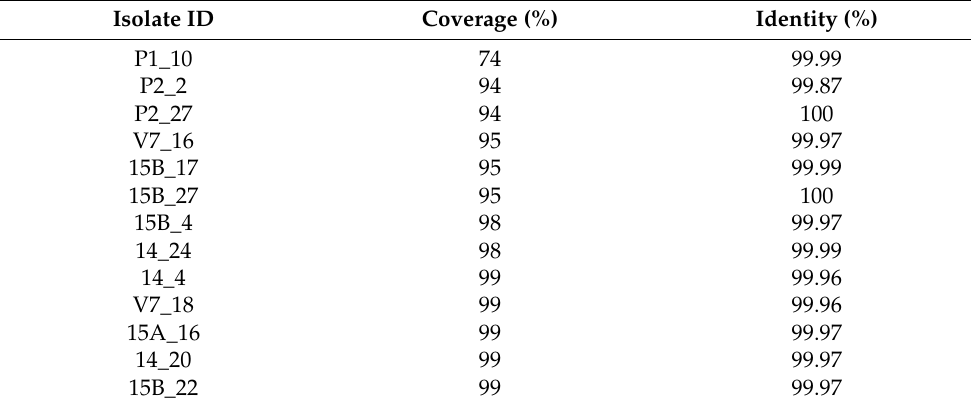
Table 2. Coverage and identity comparison of the farmer’s mcr -1-IncX4 plasmid versus livestock IncX4 plasmids.